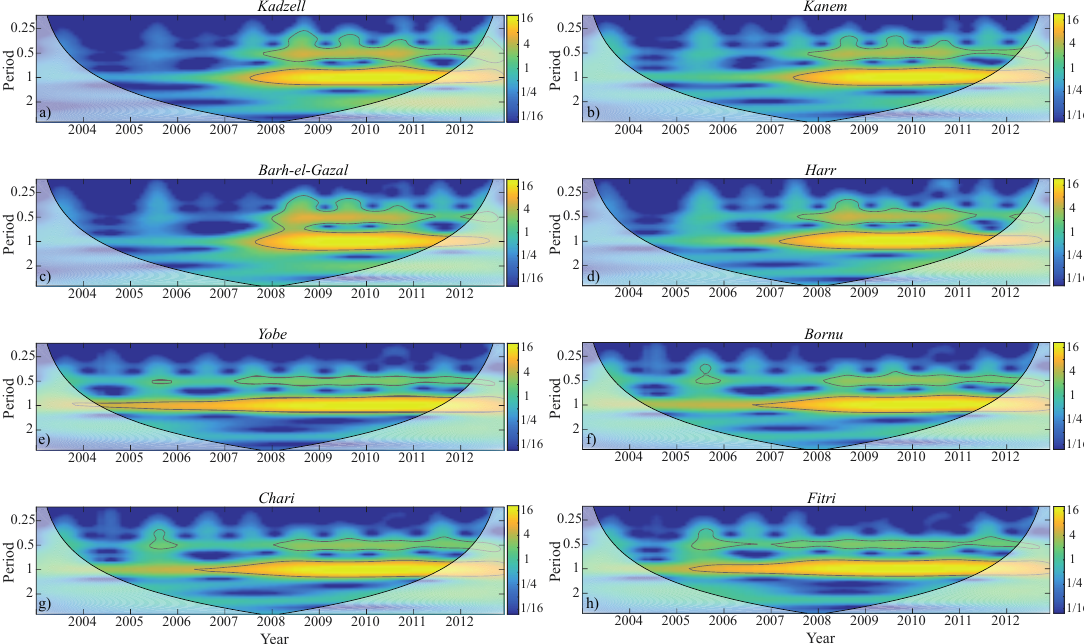
Figure 12. Same as Figure 3 for the MODIS ET